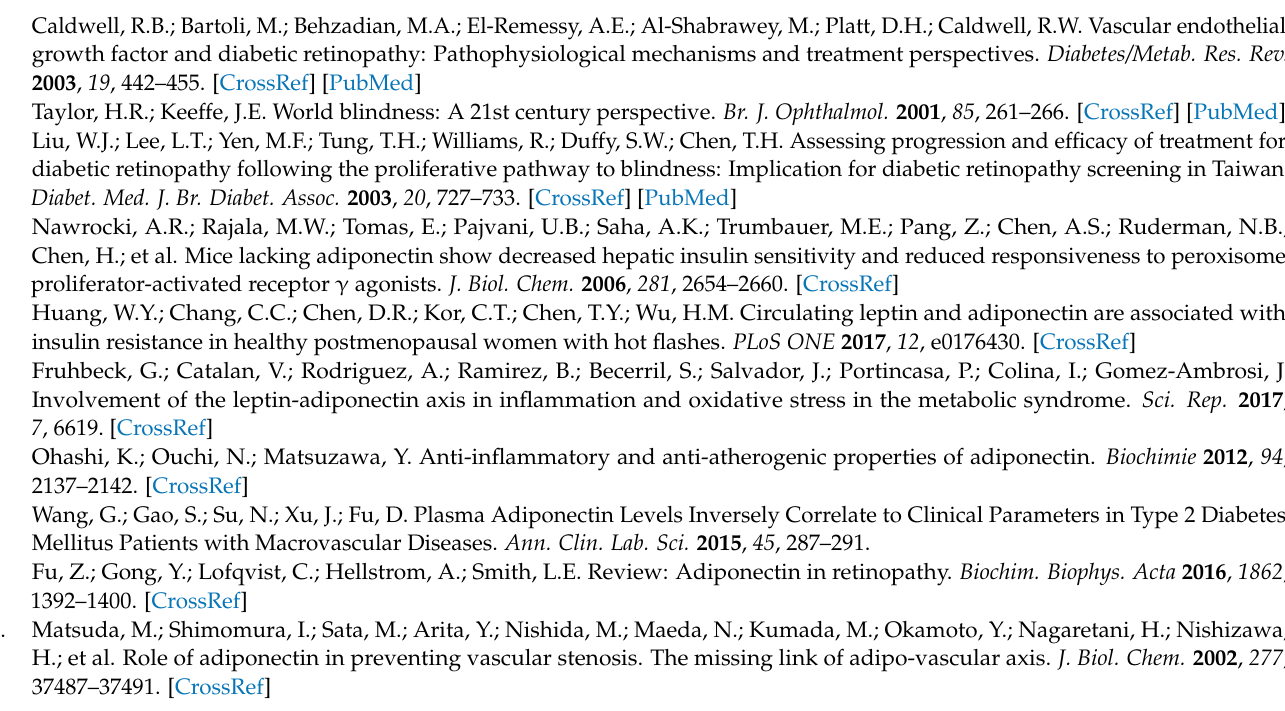
population. Table S4: Selected SNPs for each instrument variable. Figure S1: Flowchart for identifying genetic variants. Table S5: Association between the instruments and potential risk factors. Table S6: The association of adiponectin on diabetic retinopathy risk using Mendelian randomization. (Limit subjects confirmed by